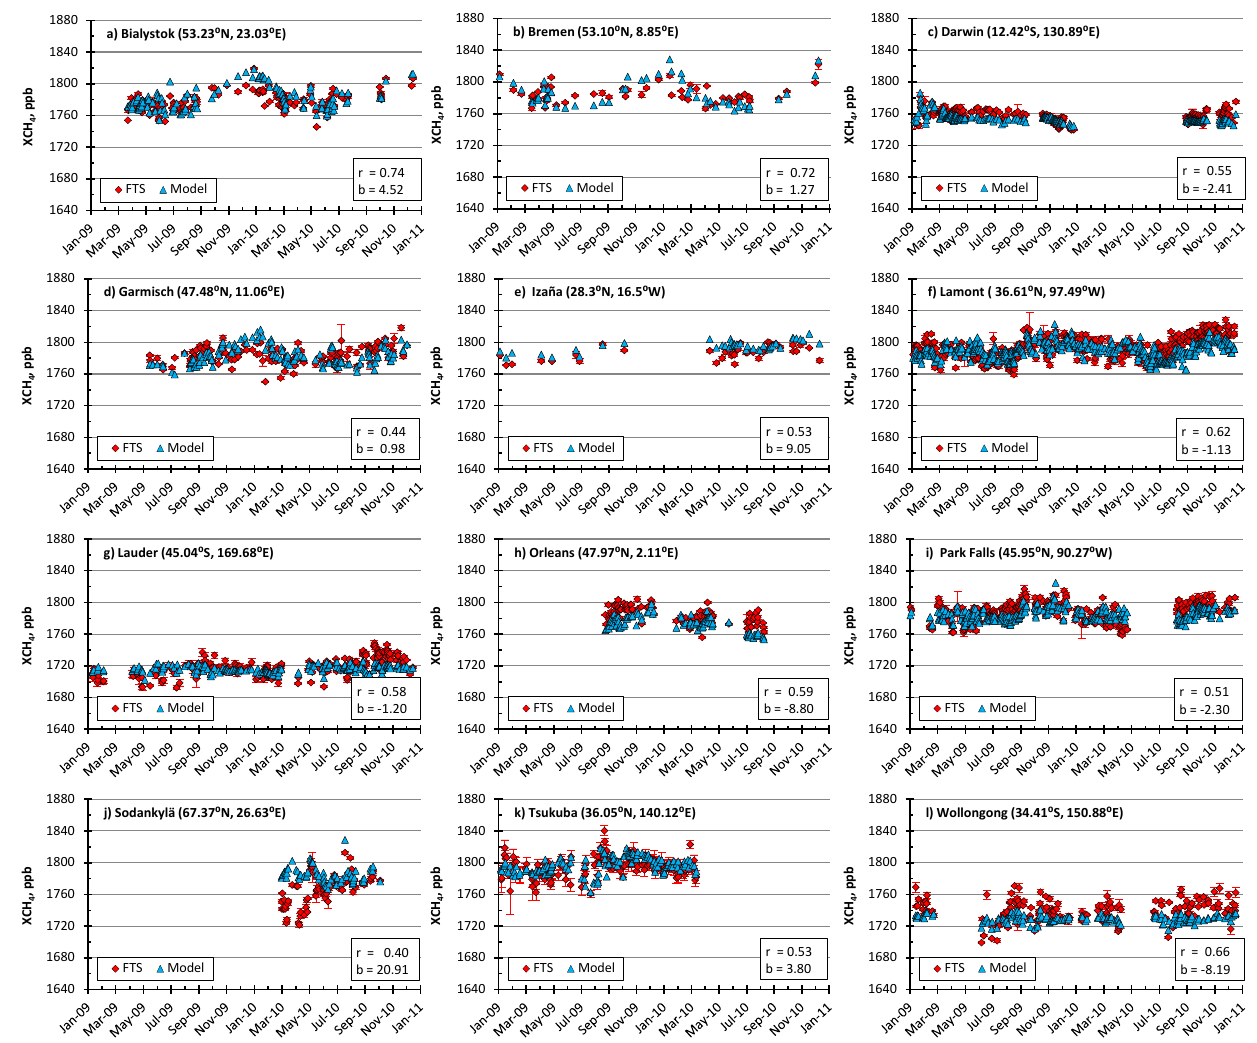
Fig. 10. Time series of XCH 4 measured by FTS and modelled by NIES TM for the period January 2009 to February 2011, for the following stations: (a) Bialystok (Poland, 53.22 ◦ N, 23.13 ◦ E); (b) Bremen (Germany, 53.10 ◦ N, 8.85 ◦ E); (c) Darwin (Australia, 12.42 ◦ S, 130.89 ◦ E); (d) Garmisch (Germany, 47.48 ◦ N, 11.06 ◦ E); (e) Iza˜na (Spain, 28.30 ◦ N, 16.50 ◦ W); (f) Lamont (USA, 36.6 ◦ N, 97.49 ◦ W); (g) Lauder (New Zealand, 45.04 ◦ S, 169.68 ◦ E); (h) Orleans (France, 47.97 ◦ N, 2.11 ◦ (e) ; (i) Park Falls (USA, 45.95 ◦ N, 90.27 ◦ W); (j) Sodankyl ¨ a (Finland, 67.37 ◦ N, 26.63 ◦ E); (k) Tsukuba (Japan, 36.05 ◦ N, 140.12 ◦ E); and (l) Wollongong (Australia, 34.41 ◦ S, 150.88 ◦ E). The “error” for each symbol is a combination of the spread due to weighted averaging within the 13:00 ± 1h local time interval and observation